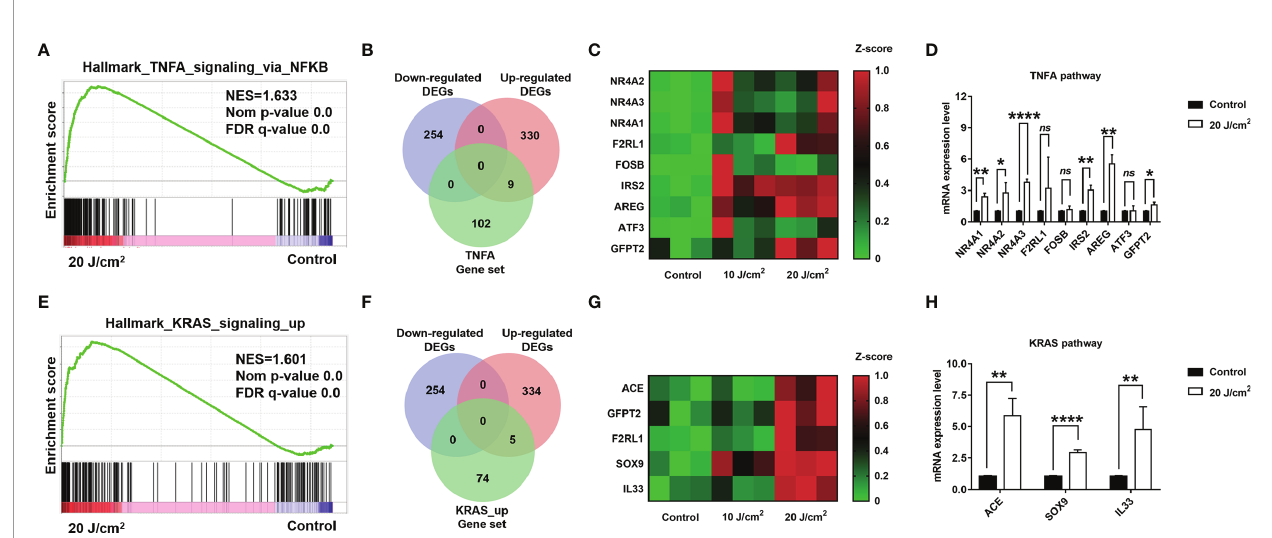
FIGURE 7 | (A) Enrichment score pro fi le of enriched pathway, TNFA_signaling_ via _NFKB. (B) Venn diagram of overlapped genes among DEGs and leading edge gene set. (C) Heatmap of overlapped gene expression level. (D) Quanti fi cation for mRNA levels of DEGs in TNF- a /NF- k B pathway (dose 20 J/cm 2 ). (E) Enrichment score pro fi le of enriched pathway, KRAS_signaling_up. (F) Venn diagram of overlapped genes among DEGs and leading-edge gene set. (G) Heatmap of overlapped gene expression level. (H) Quanti fi cation for mRNA levels of DEGs in KRAS_signaling_up pathway (dose 20 J/cm 2 ). *p<0.05; **p<0.01; ****p<0.0001; ns, no signi fi